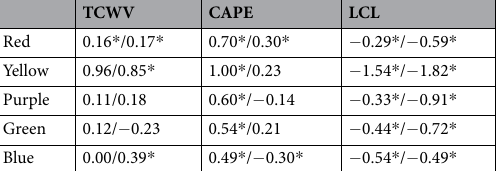
Table 2. Standardized partial regression coefficients a of wet season precipitation Prcp with wet season TCWV, CAPE and LCL at the ERA-Int cells/MERRA2 cells. * represents statistically significant values at 90% confidence level. a Standardized partial regression coefficient is computed as: Partial regression coefficient b1 (b2, b3) × standard deviation of TCWV (CAPE, LCL) ÷ standard deviation of Prcp